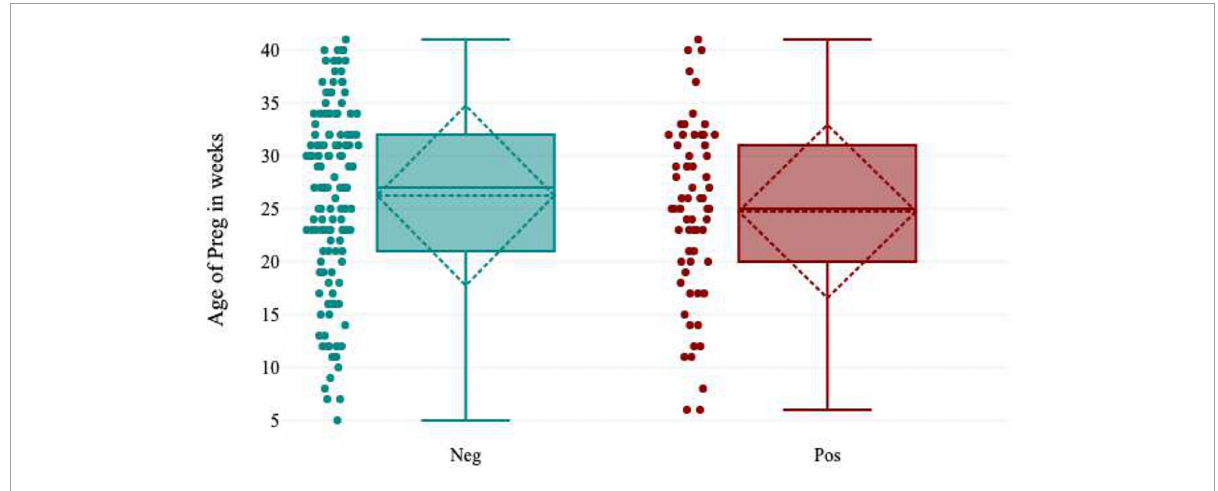
FIGURE4 Box-plot showing gestation age of HEV IgG seropositivity